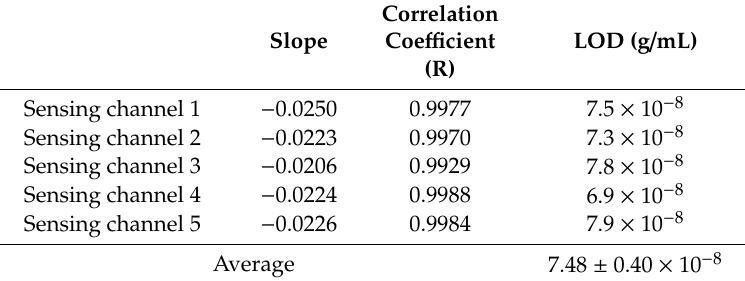
Table 4. Performance of the multi-microchannel FOPPR sensor system for detection of anti-DNP / DNP